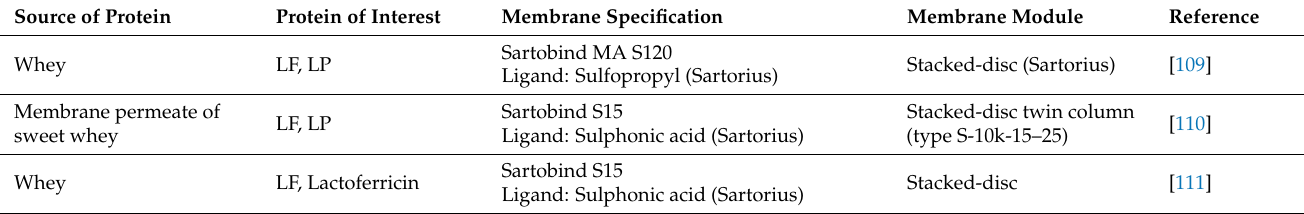
Table 4. Fractionation of proteins from whey by cation-exchange